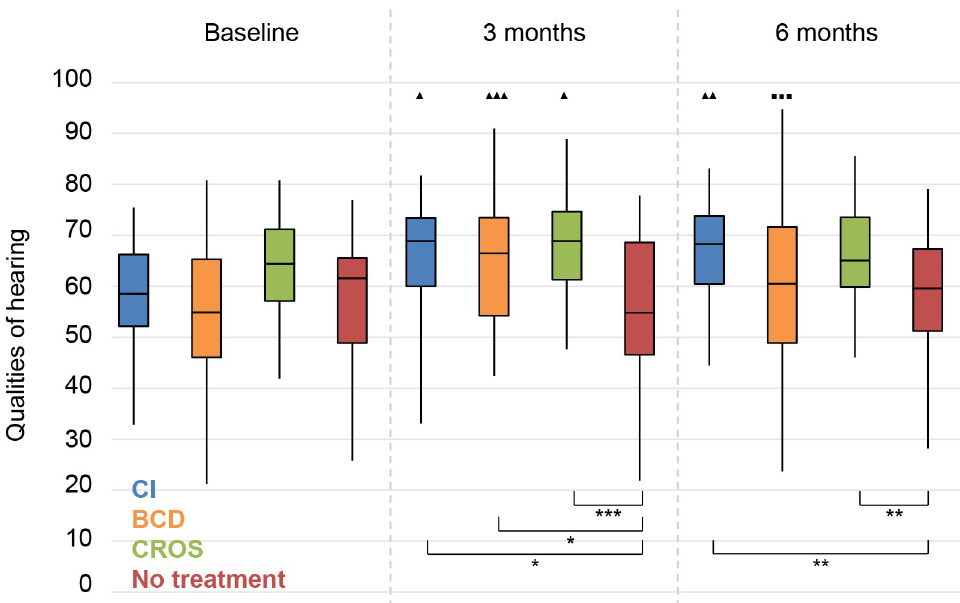
Fig 12. Speech, Spatial and Qualities of hearing questionnaire (SSQ). Qualities of Hearing subscale. Statistical difference compared to baseline. ▲▲▲ = p < 0.001; ▲▲ = p < 0.01; ▲ = p < 0.05. Statistical difference compared to 3 months follow-up. ■■■ = p < 0.001; ■■ = p < 0.01; ■ = p < 0.05. Statistical difference between groups at same follow-up moment. ��� = p < 0.001; �� = p < 0.01; � = p < 0.05.